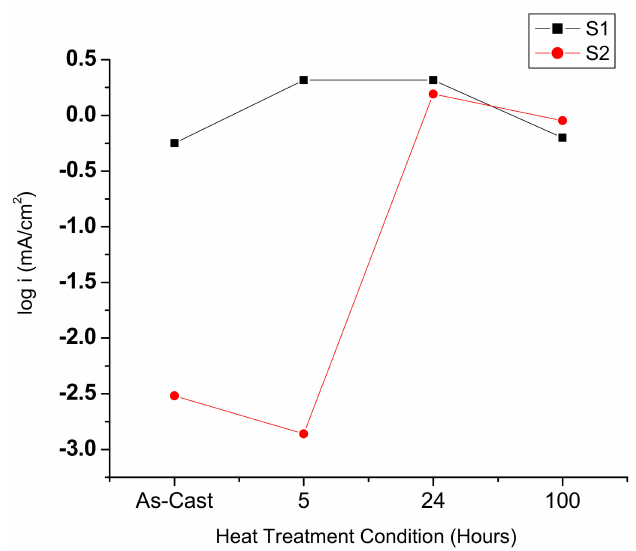
Figure 8. Current density as a function of heat treatment